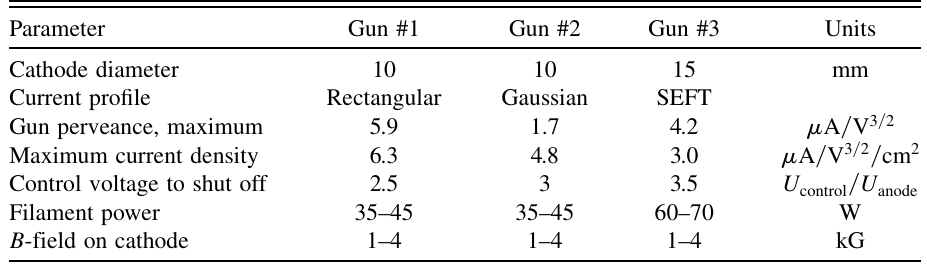
TABLE II. Main parameters of the TEL